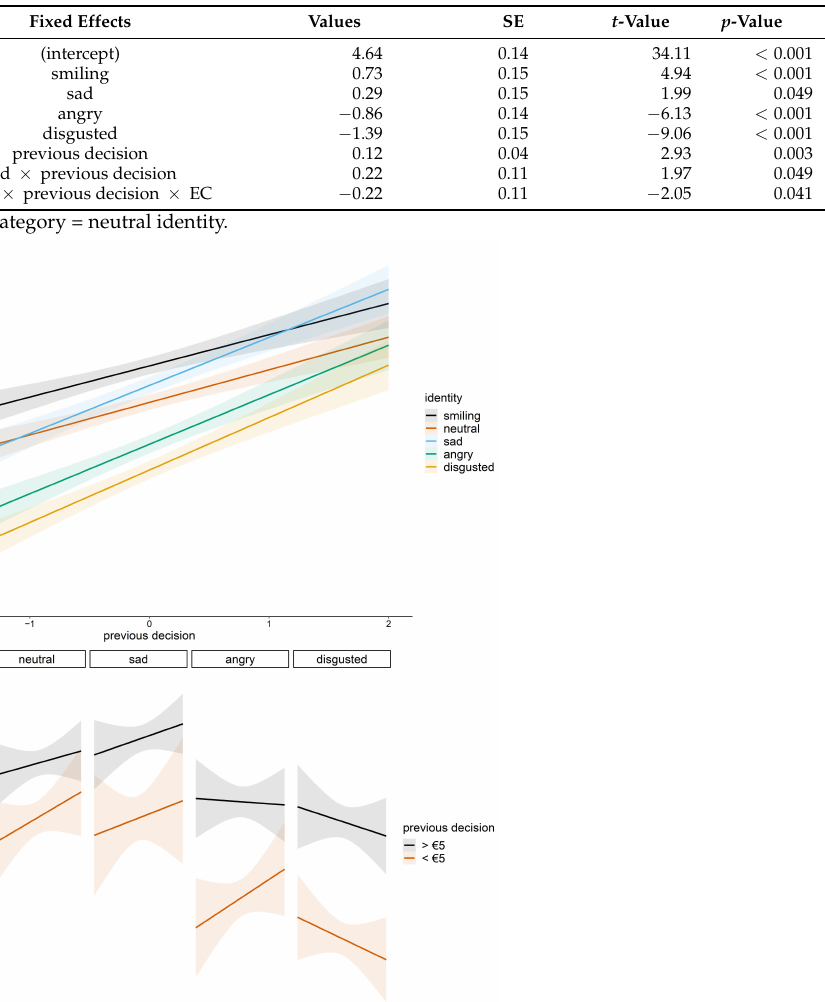
Figure 1. Boxplots of decisions of dictators toward the five different recipient identities. The dots within the boxes indicate the mean per recipient identity. Table 2. Intercept and significant fixed effects for the trial-by-trial analysis on dictator behavior.